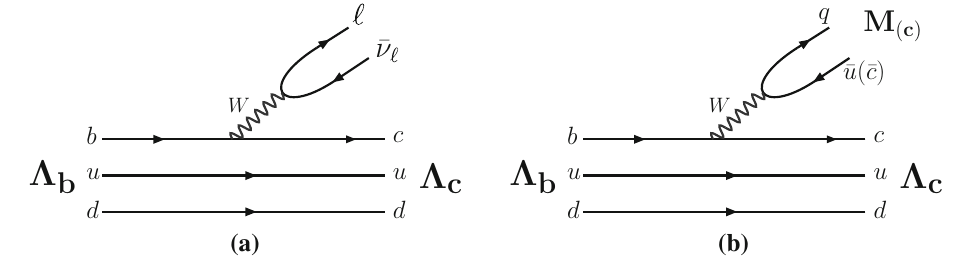
Fig. 1 Feynman diagrams depicted for a (cid:2) b → (cid:2) c (cid:3) ¯ ν (cid:3) and b (cid:2) b → (cid:2) c M ( c )